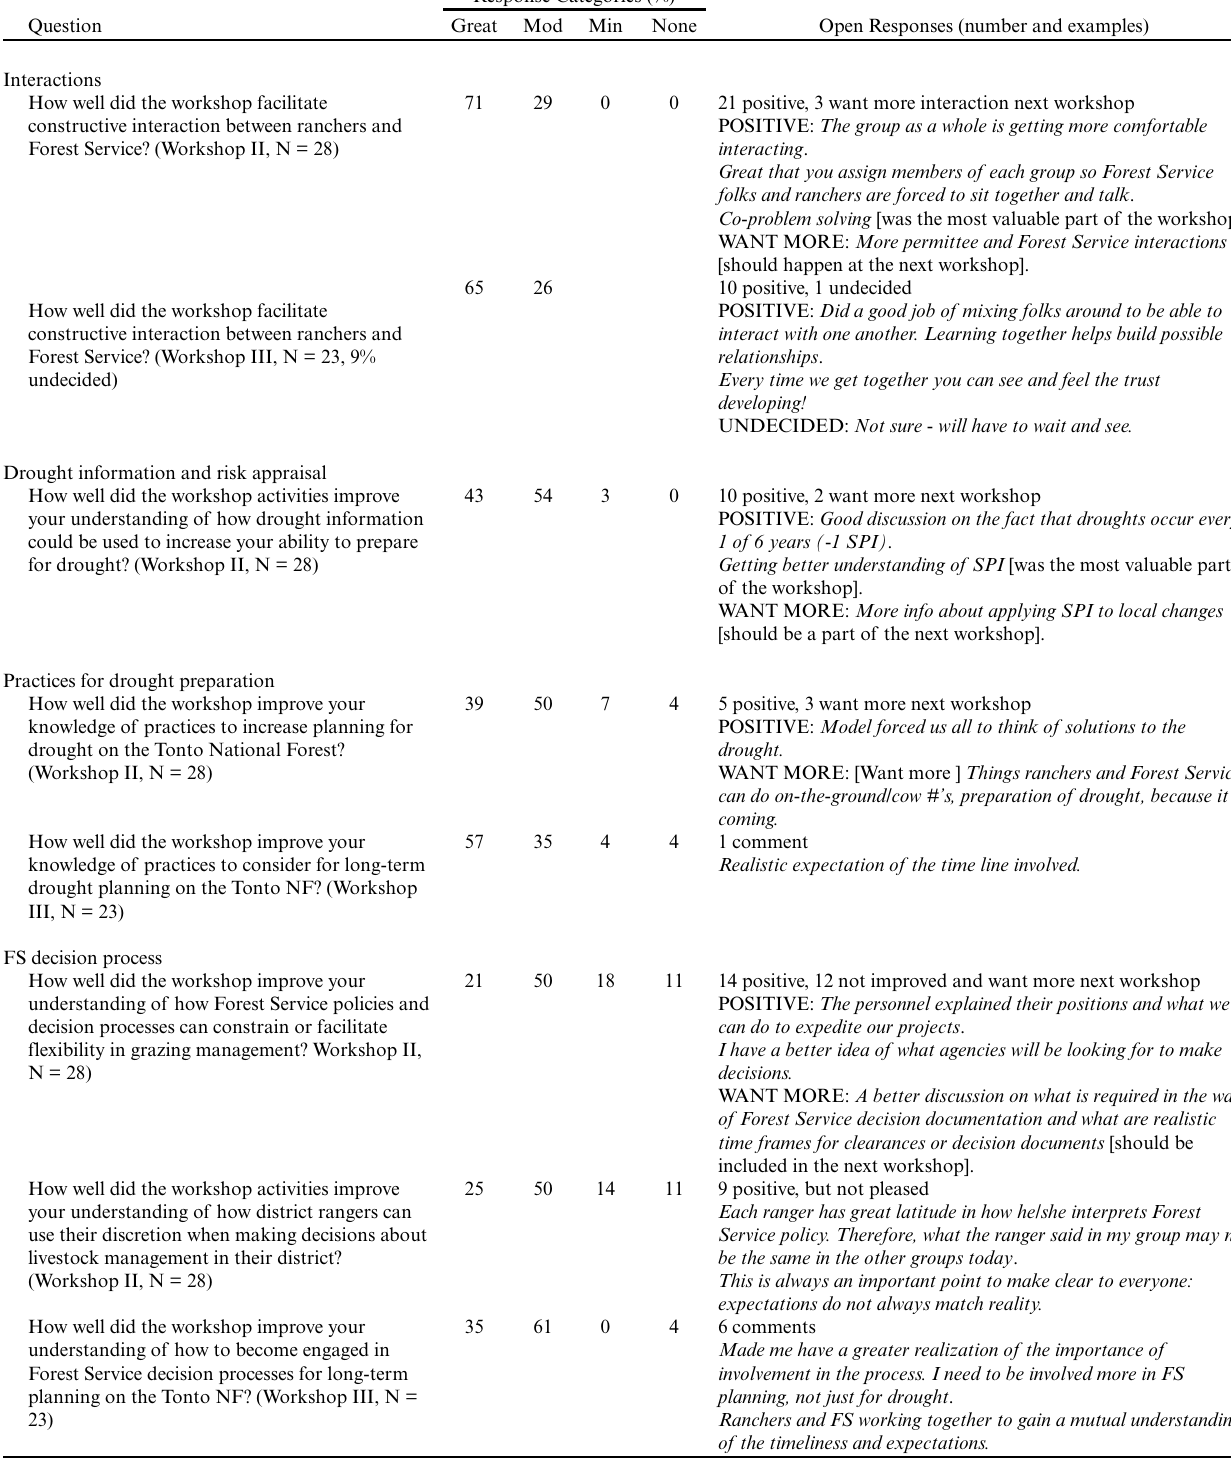
Table 2 . Results of workshop evaluations (only two undecided in interactions for workshop III). The four Likert-scale categories range from strongest to weakest support for a statement: greatly (great), moderately (mod), minimally (min), and not at all (none). Response Categories (%) Question Great Mod Min None Open Responses (number and